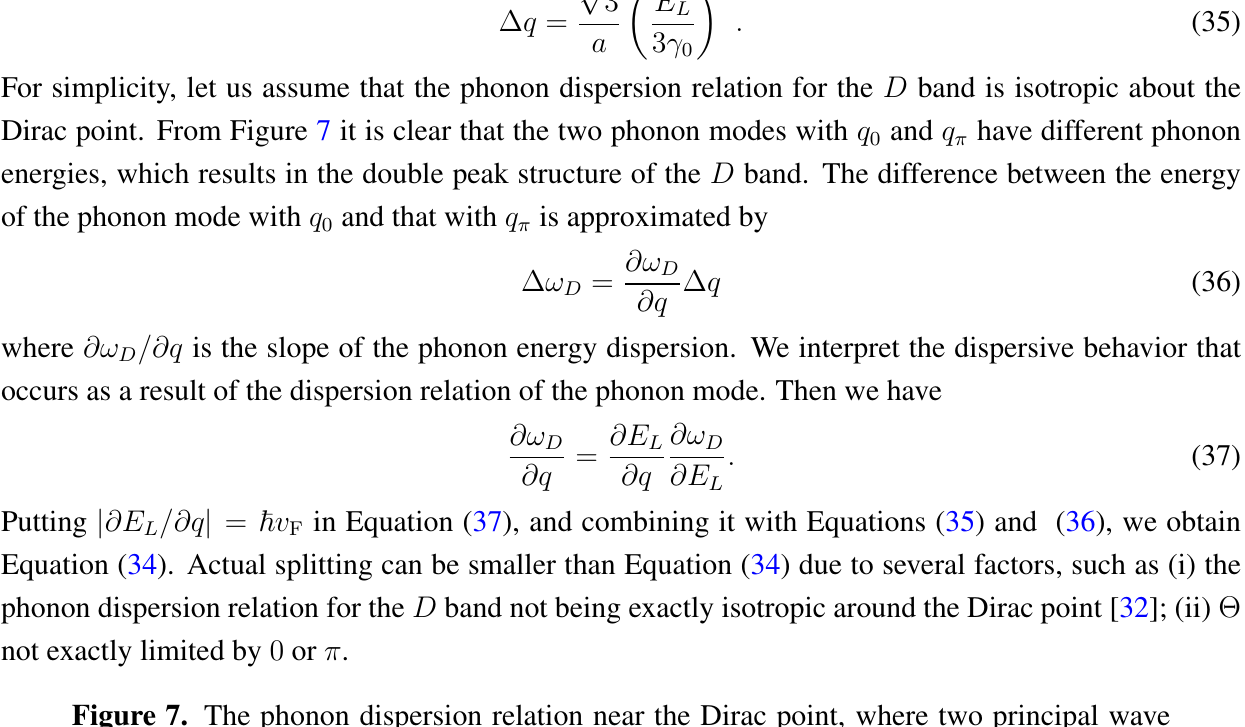
Figure 7. The phonon dispersion relation near the Dirac point, where two principal wave vectors of the phonons ( q and q ) contribute to the D band. The energy difference 0 (cid:25)